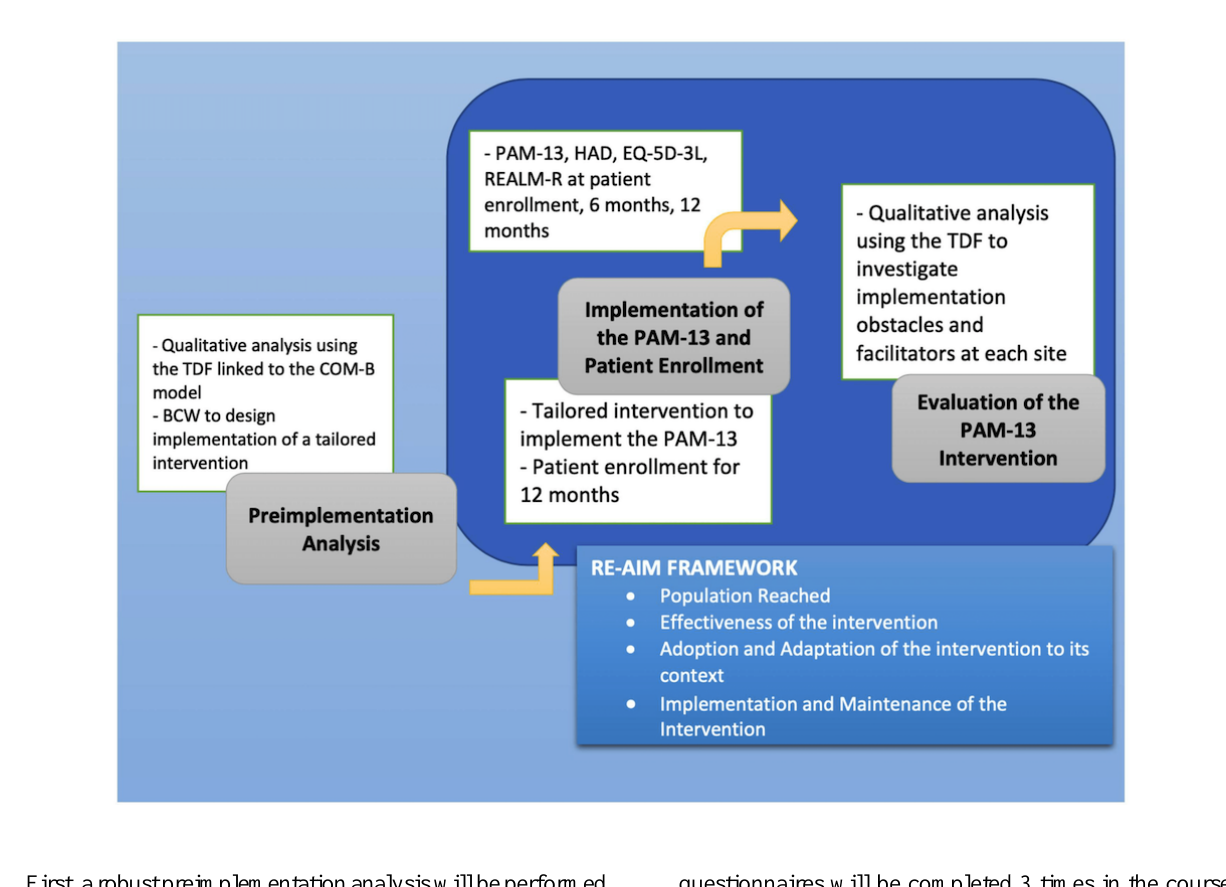
Figure 1. Overall design of the PARACT (PARAmedical Interventions on Patient ACTivation) multicentric